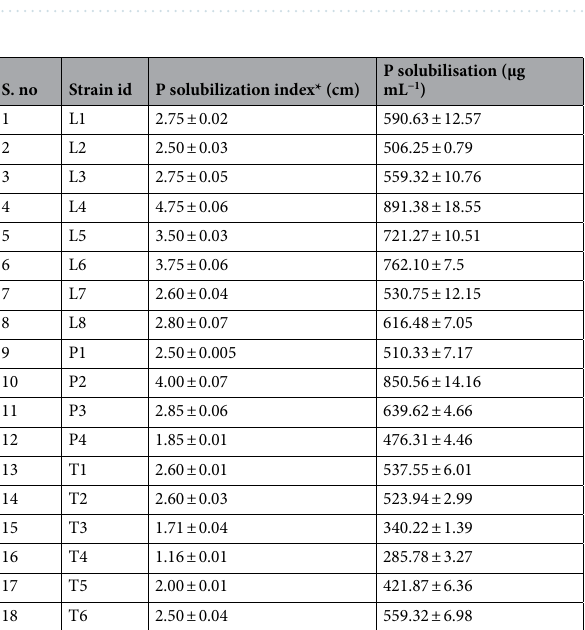
Figure 1. Qualitative efficiency of PSB bacterial isolates depicting halo zone around bacterial colonies on Pikovskaya agar plate.